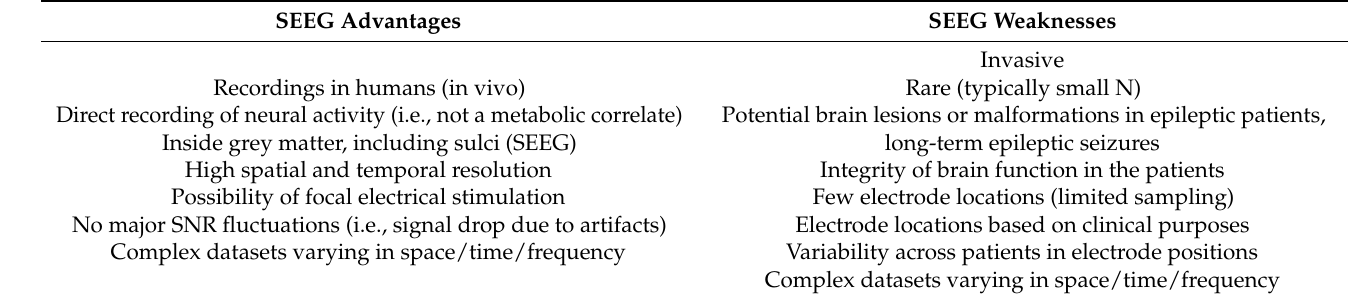
Table 1. Advantages and weaknesses of intracerebral recordings with SEEG. Note that these charac- teristics are similar to